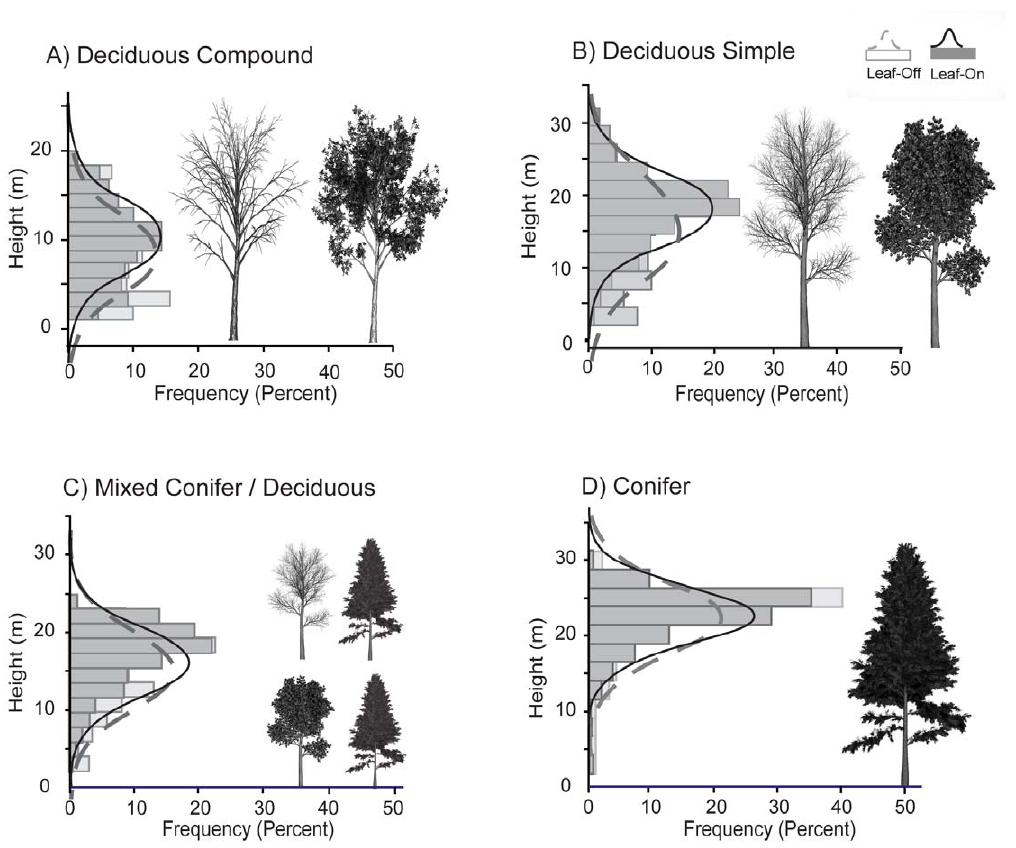
Figure 4. Example distributions of canopy laser pulse returns in leaf-off compared to leaf-on conditions in an A) deciduous compound and B) deciduous simple C) mixed conifer/deciduous and D) conifer plots. Example distributions are representative of conditions observed within all plots for each vegetation type.